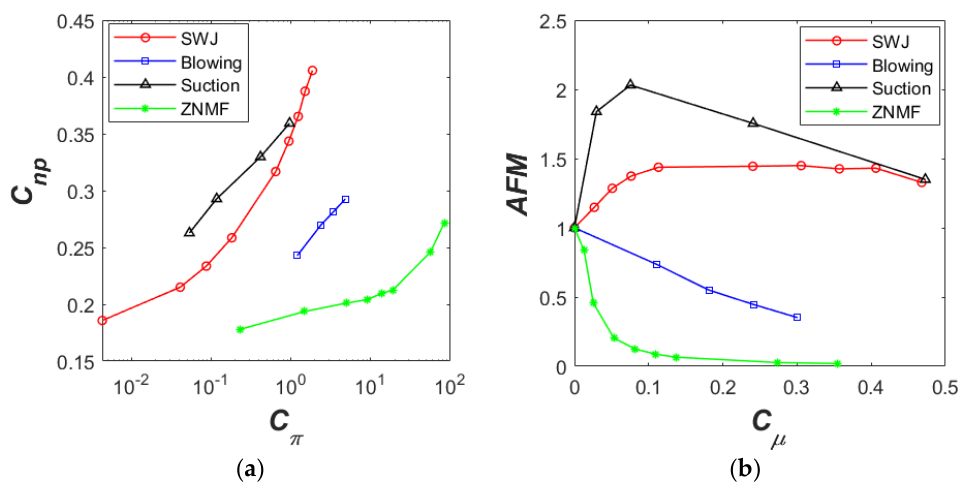
Figure 15. Comparison of the AFC actuator performance: ( a ) modified normal force coefficient; ( b ) aerodynamic figure of merit.